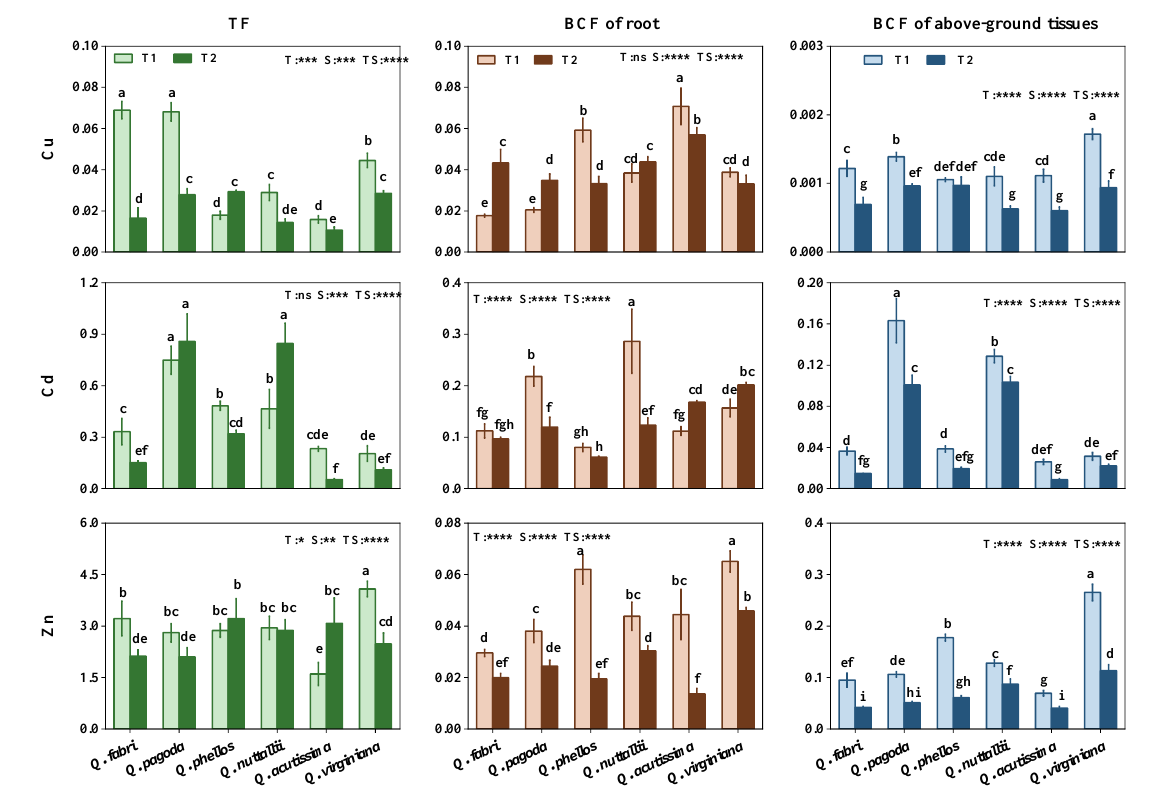
Figure 4. Translocation factor (TF) and bioaccumulation factor (BCF) of six Quercus species cultivated in control, T1 (mixture of clean and polluted soil, 50%), and T2 (100% polluted soil) treatments for 150 d. Data represent the mean of three replicates ± SD (n = 3). p values of the two-way ANOVAs of soil treatments (T), Quercus species (S), and their interactions (T × S) were also shown. ns, not significant; *, p ≤ 0.05; **, p ≤ 0.01; ***, p ≤ 0.001; ****, p ≤ 0.0001. The different letters showed the significance at level of 0.05.